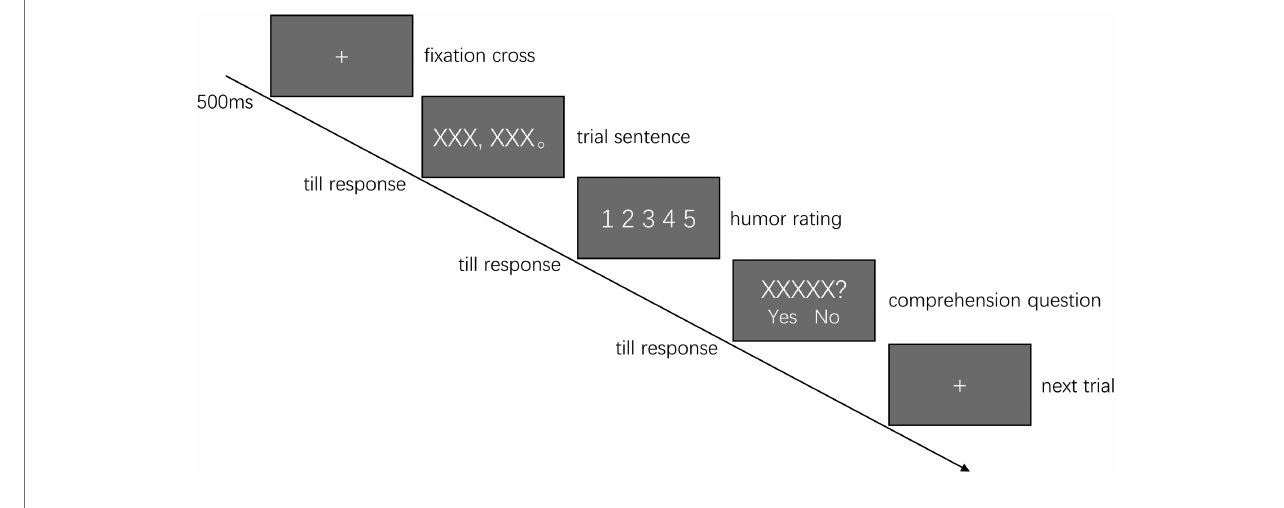
FIGURE 1 | An illustration of the experiment paradigm.